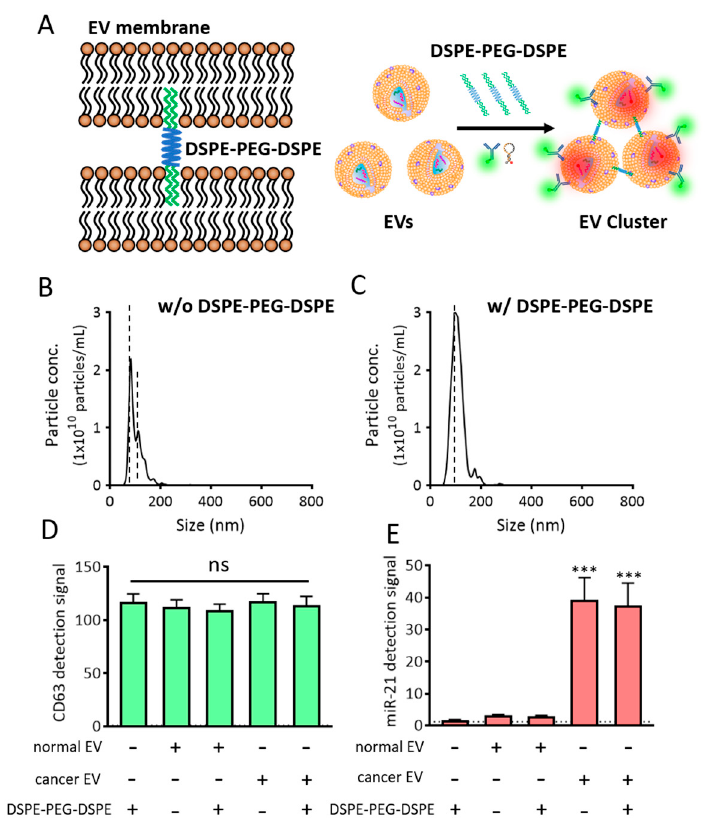
Figure 6. EV cluster formation using DSPE-PEG-DSPE. ( A ) Schematic representation of DSPE-PEG-DSPE-induced EV cluster formation and single step detection of EV biomarkers in clustered EVs using flow cytometry. ( B , C ) NTA analysis of cancer particle size distribution in the absence ( B ) and presence ( C ) of DSPE-PEG-DSPE. Note that the EV clusters were observed to be larger than single EVs. ( D , E ) Effects of DSPE-PEG-DSPE on the fluorescent signals for CD63 ( D ) and miR-21 ( E ), as assessed using a fluorometer. All values are expressed as mean ± SD ( *** p < 0.001; ns: Not significant; n = 3–6).